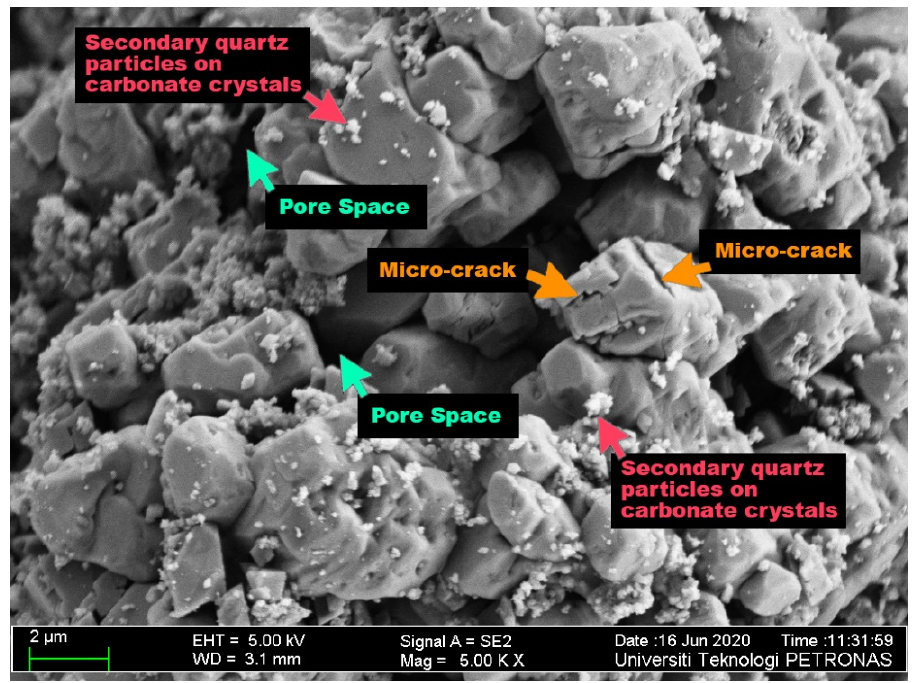
Figure 7. FESEM image of sample A-1.3 before permeability measurement.